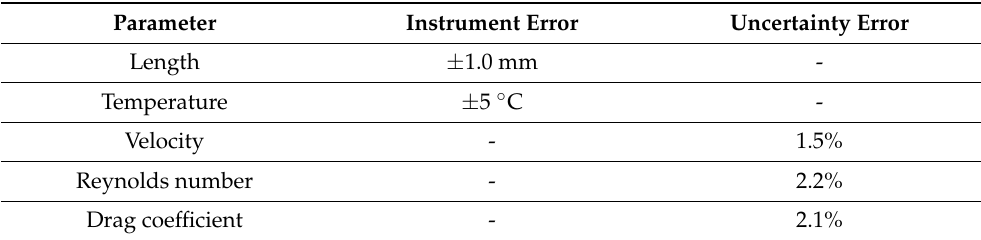
Table 1. Instrument error and error